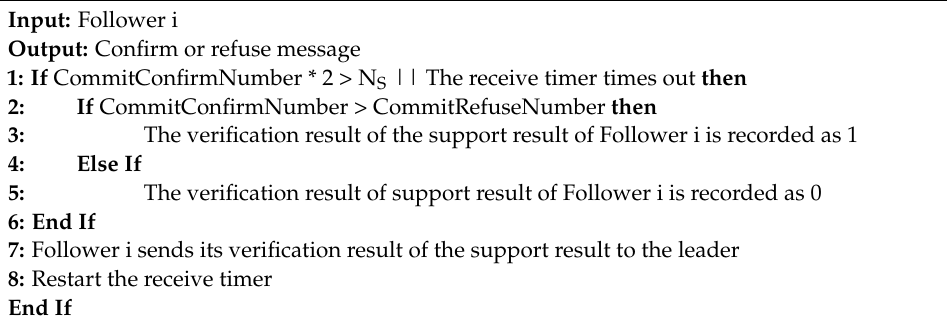
Algorithm 7. The follower support result verification behavior of the modified PBFT